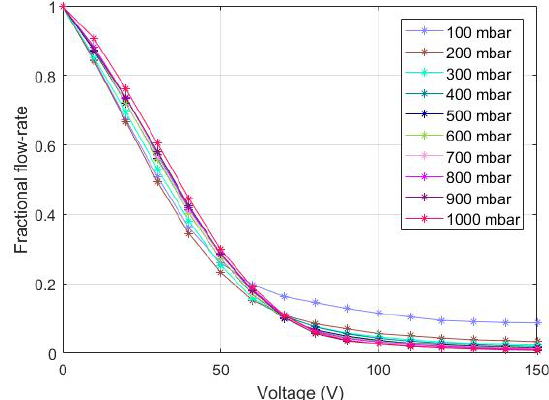
Figure A3. Fractional reduction in flow-rate at different